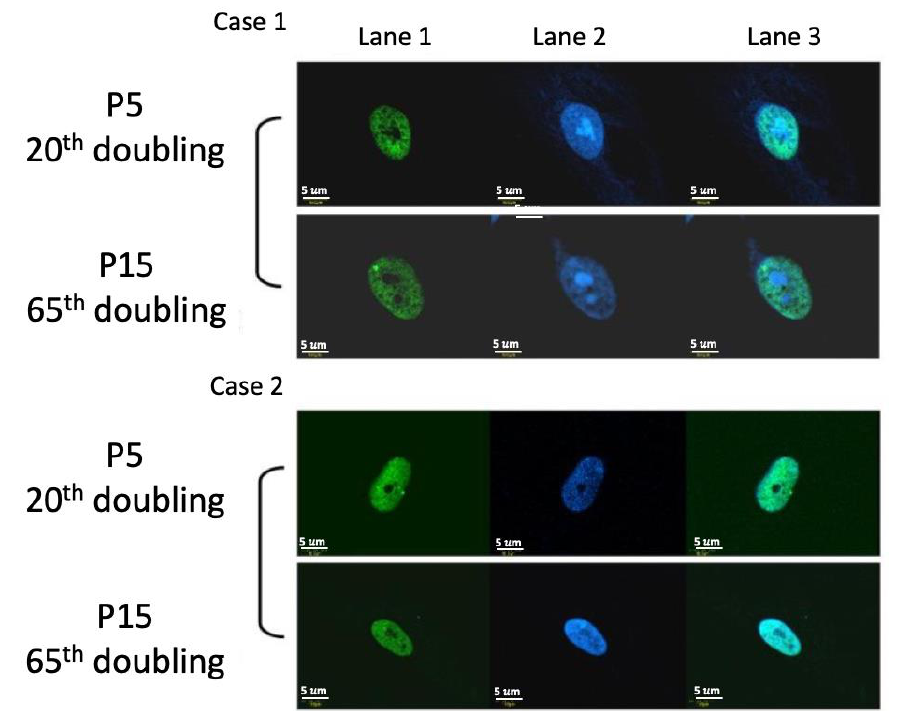
Figure 7. Immunostaining of 53BP1. The figure showed 2 cases of HBMSCs in P5 and P15. The green color (Lane 1) showed the positive staining of anti-53BP1 and the blue color (Lane 2) showed the staining of DAPI. The Lane 3 showed the merge image of anti-53BP1 and DAPI.